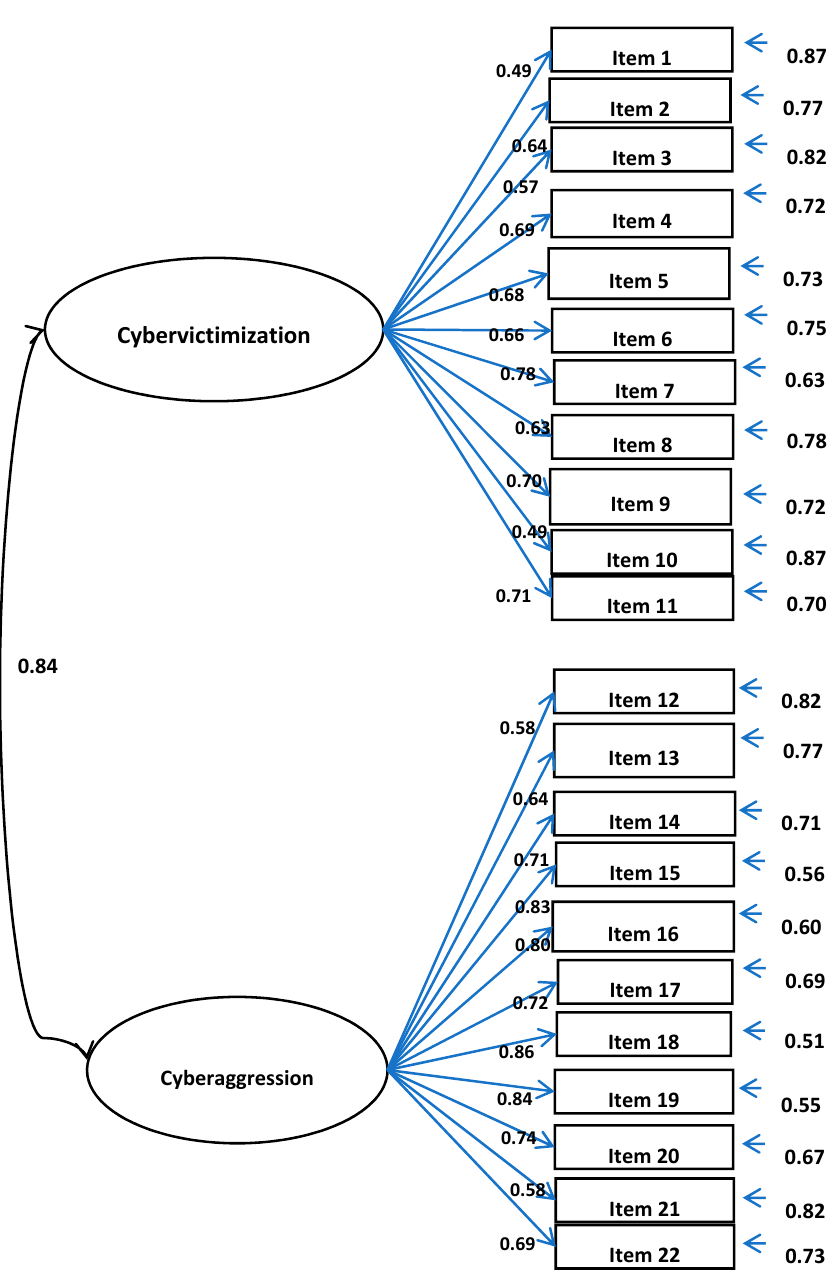
Figure 2. Figure 2. Confirmatory Factor Analyses of the European Cyberbullying Intervention Project Questionnaire.